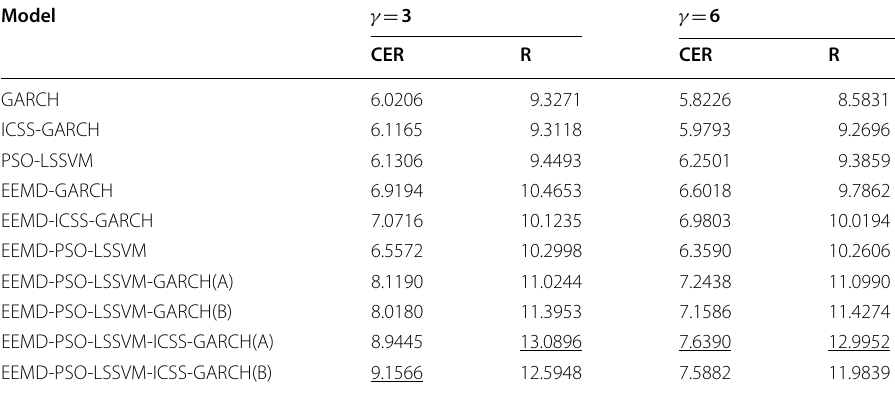
Table 9 Portfolio performance based on the various AIRO index return forecasting models including transaction